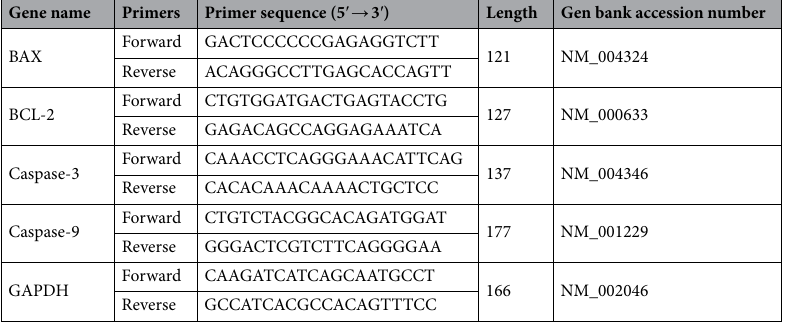
Table 3. Sequences and properties of primers used in